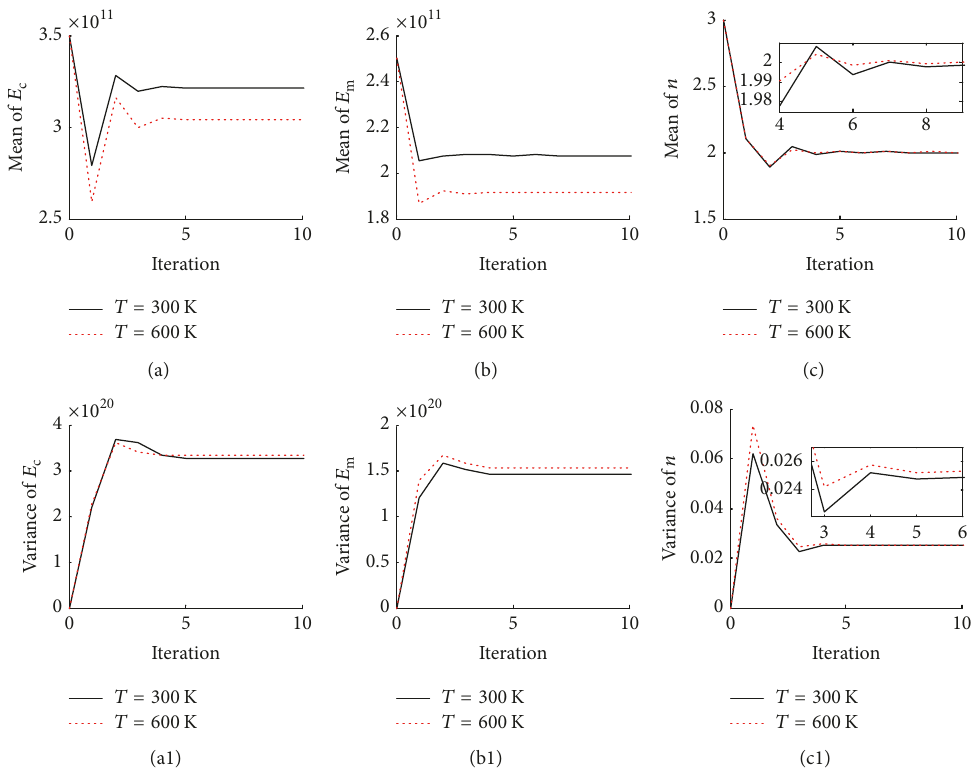
Figure 4: Iterative process of means and variances of material elastic moduli and volume fraction